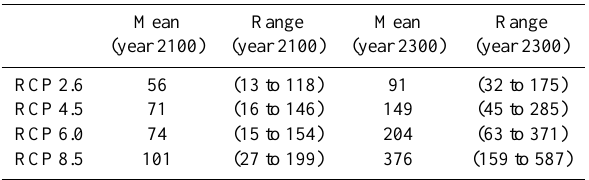
Table 2. Peak emission rate of carbon from permafrost soils for each RCP scenario. Ranges are 5th to 95th percentiles. All values are inPgCa − 1